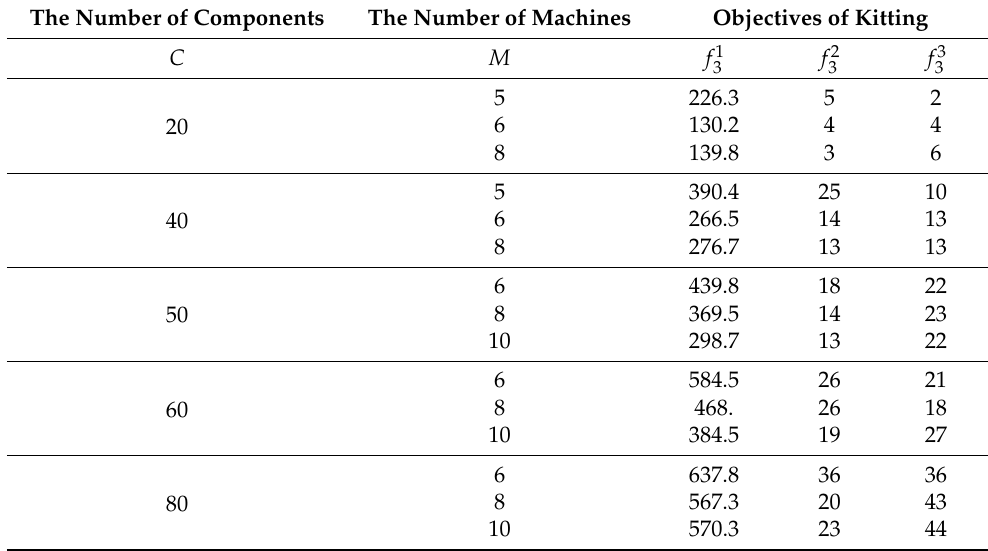
Table 2. Computational results for small-size instances.